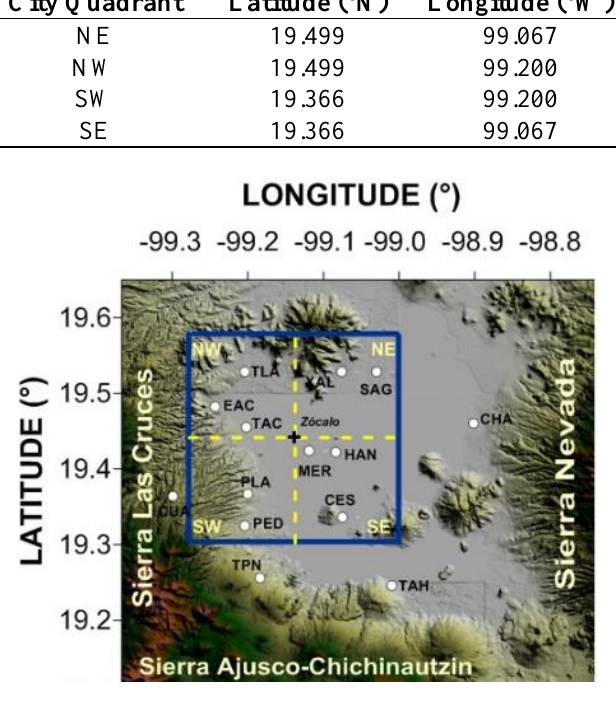
Figure 3. The lattice domain. The blue solid rectangle represents the cell of the 1-cell LWM of Mexico City. The quadrants defined by the solid line rectangle divided by dashed lines represent the cells of the 4-cell LWM. Positions (white solid circles) and IDs of the REDMET stations are also